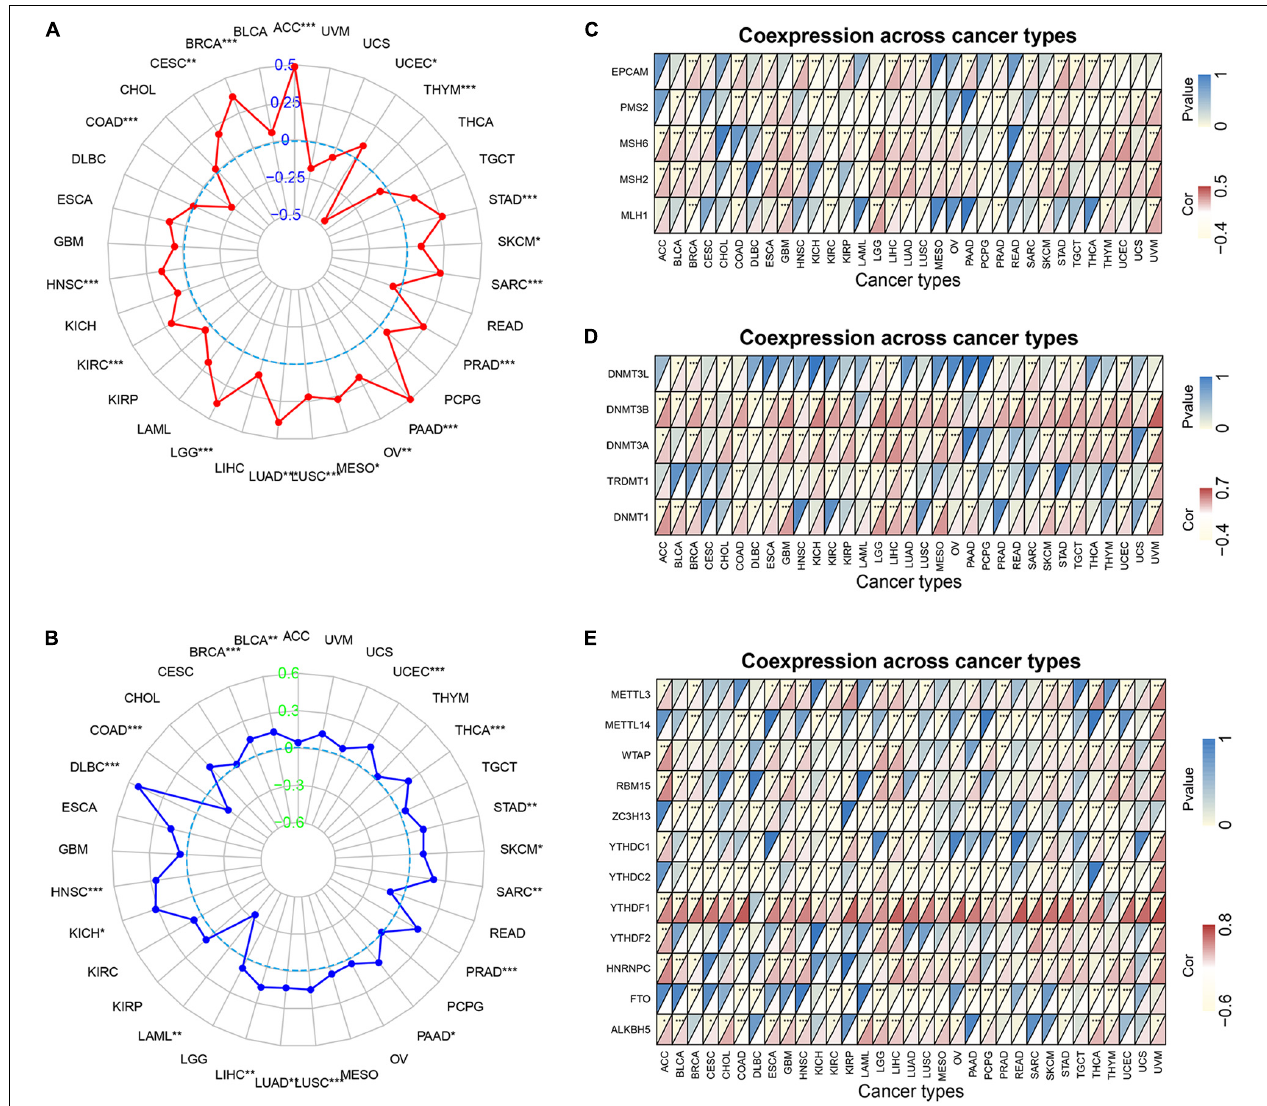
FIGURE 7 | Relationship between MRGBP expression and tumor mutational burden (A) , microsatellite instability (B) , MMR genes (C) , DNA methyltransferases genes (D) and mRNA m6A related genes (E) in various tumors in TCGA database. The lower triangle in each tile indicates coefficients calculated by Pearson’s correlation test, and the upper triangle indicates log 10 -transformed P -value (*** P < 0.001, ** P < 0.01, * P <